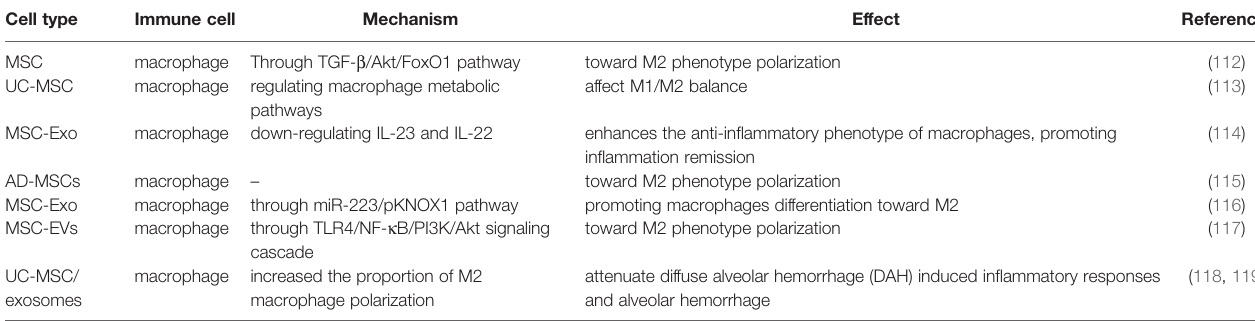
TABLE 5 | Mechanism of action with MSCs and EVs on